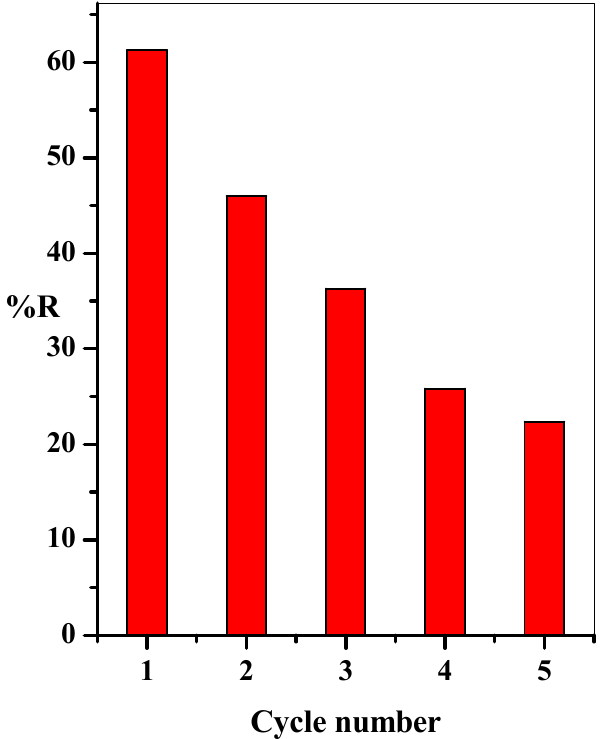
Figure 10. Effect of cycle number on the adsorption percentage of MB-dye (t = 35 min, [GO@CS] = 50 mg/50 mL, [MB] = 20 mg/L, pH= 7, T = 25 °C).